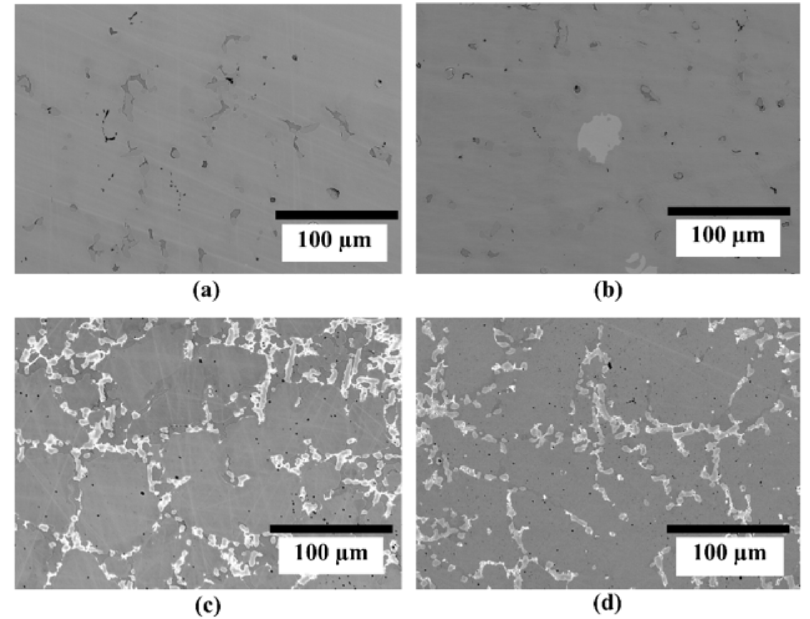
Figure 1. Back-scattered electron micrograph of TiFe alloy with ( a ) 2 wt.% V; ( b ) 4 wt.% V; ( c ) 2 wt.% Zr + 2 wt.% V; ( d ) 2 wt.% Zr + 2 wt.% V + 2 wt.% Mn as additives.